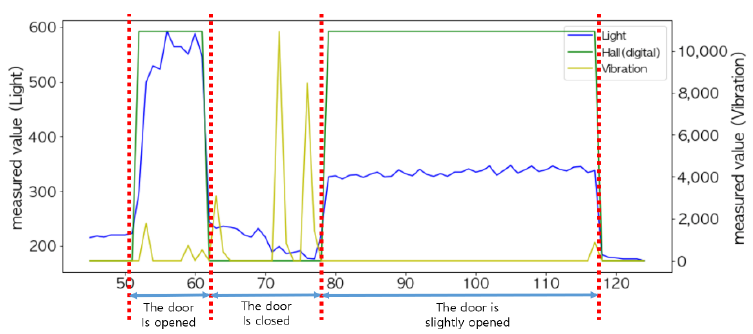
Figure 20. Determination of the state of the door ( 𝑠𝑡𝑎𝑡𝑒 𝑑𝑜𝑜𝑟 ) of the smart storage.